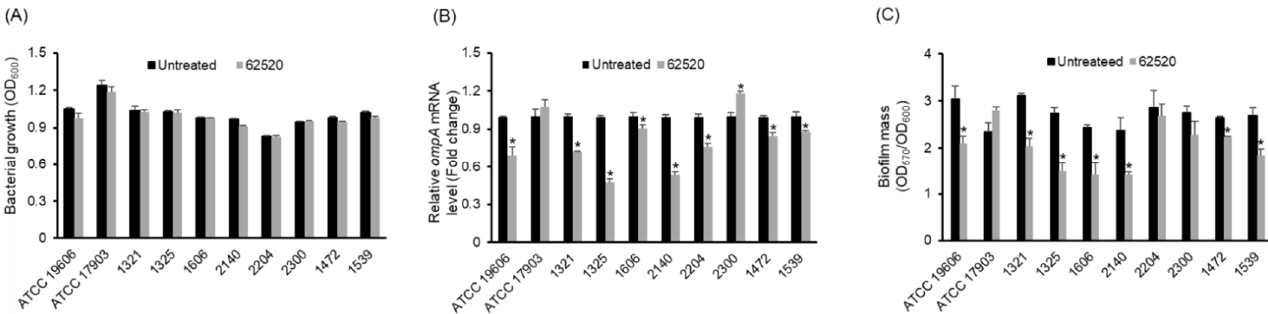
Figure 2. In Vitro activity of compound 62520 against A. baumannii ATCC 19606, A. nosocomialis ATCC 17903, and clinical CRAB isolates. ( A ) Bacteria were cultured with or without 2.8 µ g/mL of compound 62520 for 24 h and bacterial growth was measured at OD 600 . Data are presented as the mean ± SD of three independent experiments. ( B ) Bacteria were cultured with or without 2.8 μ g/mL of compound 62520 for 24 h and then total RNA was extracted. The expression levels of ompA were analyzed by qPCR. Data are presented as the mean ± SD of the expression levels of ompA in compound 62520-treated bacteria relative to those of untreated bacteria. ( C ) Bacteria were cultured with or without 2.8 μ g/mL of compound 62520 for 24 h. The biofilm mass was quantitated as the OD 570 normalized to OD 600 . For both ( B , C ), data are presented as the mean ± SD of three independent experiments. * p < 0.05 compared with the untreated bacteria.